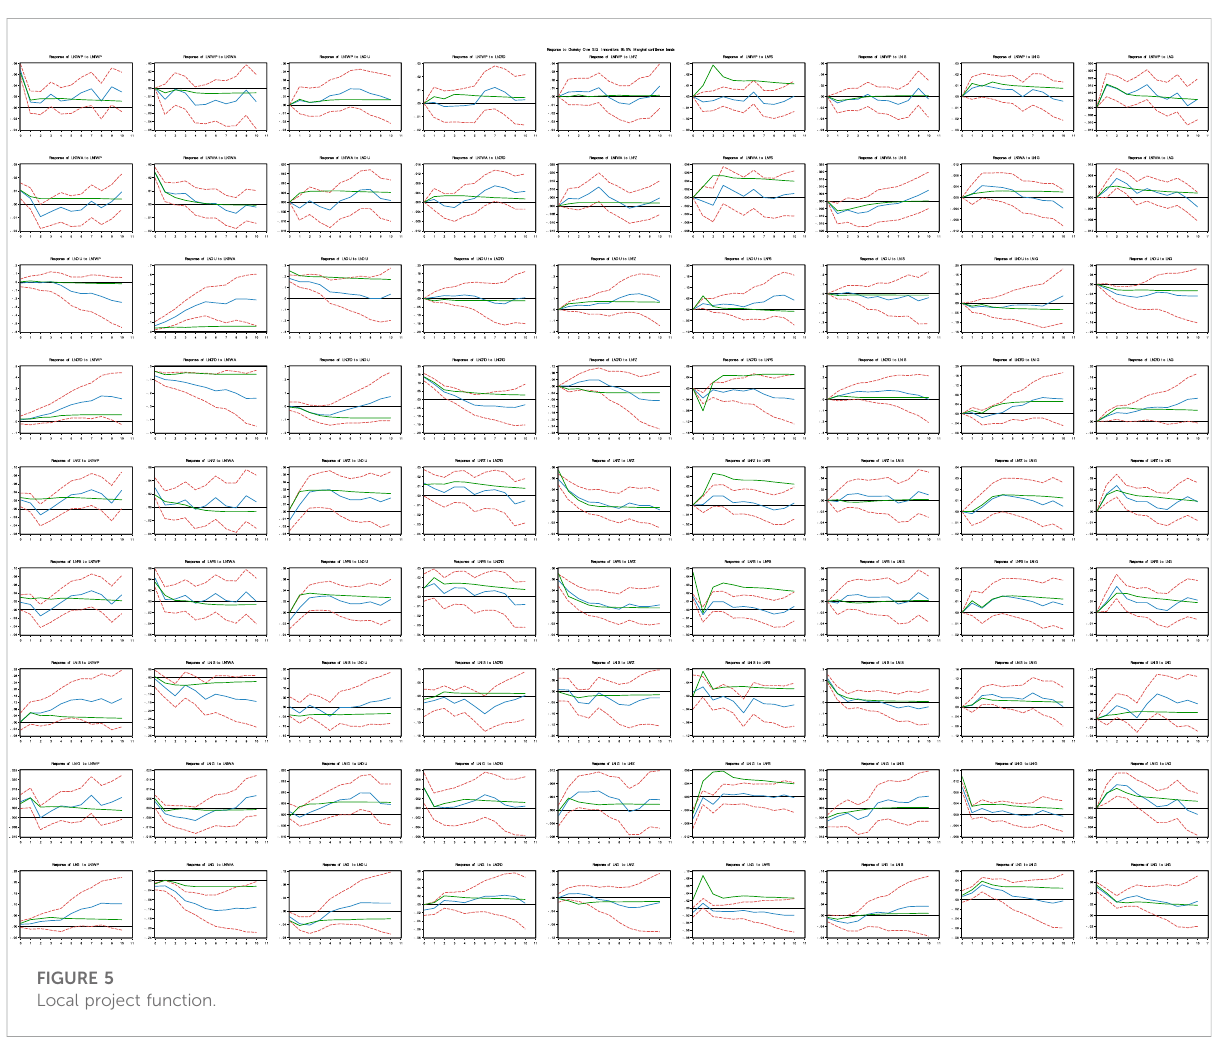
FIGURE 5 Local project function.